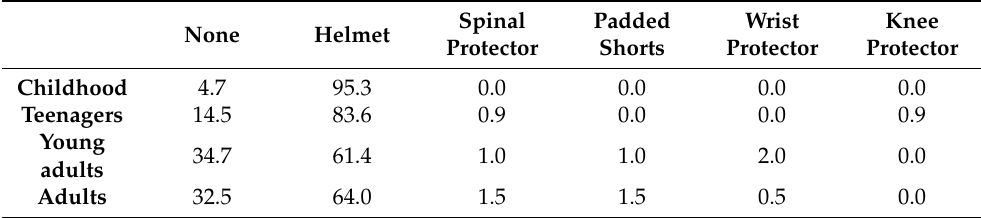
Spinal Padded Wrist Knee Protector Shorts Protector Protector